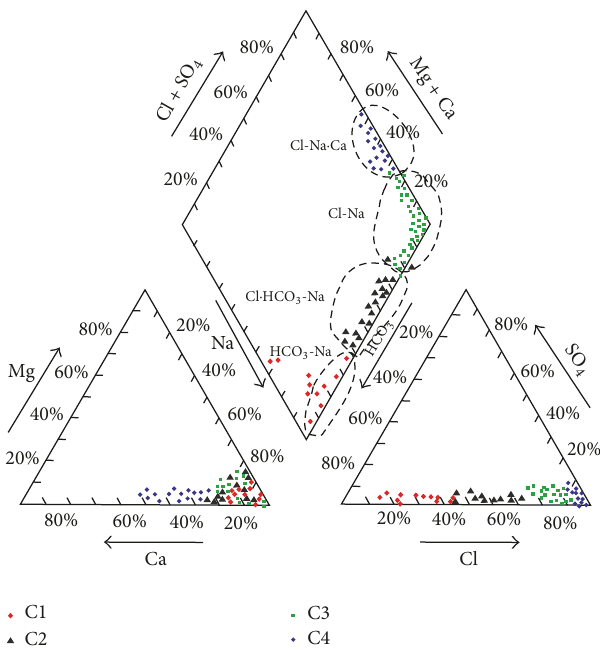
Figure 6: Piper diagram of formation water samples from buried hill of Jizhong